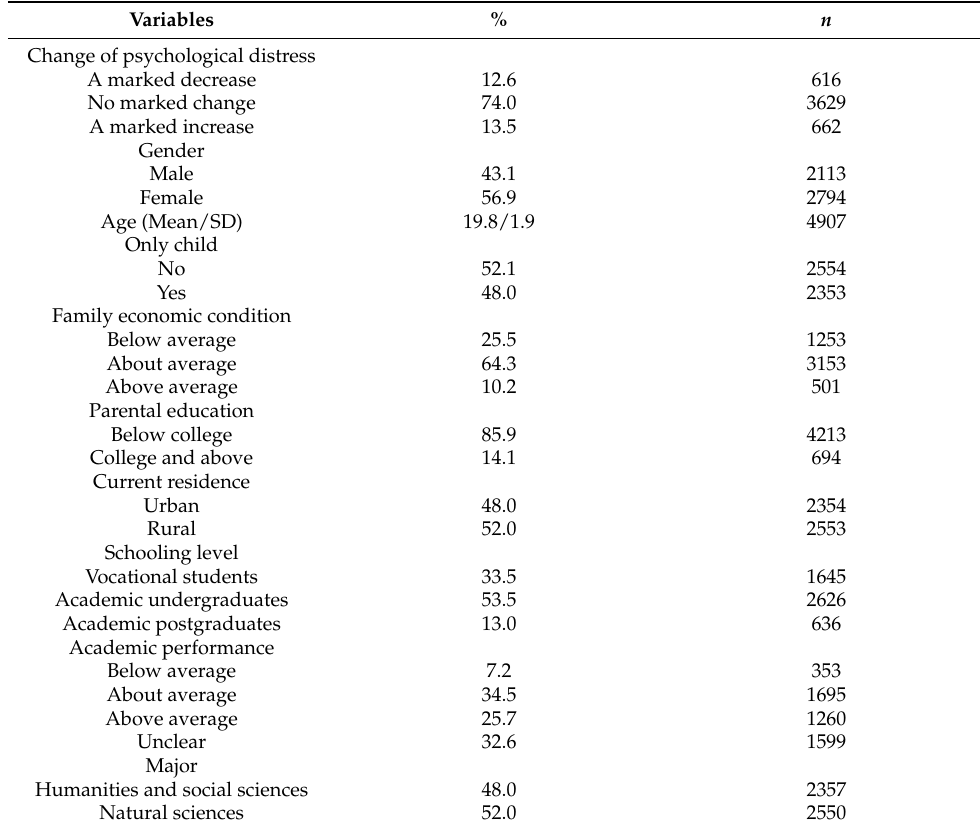
Table 1. Descriptive statistics ( n =